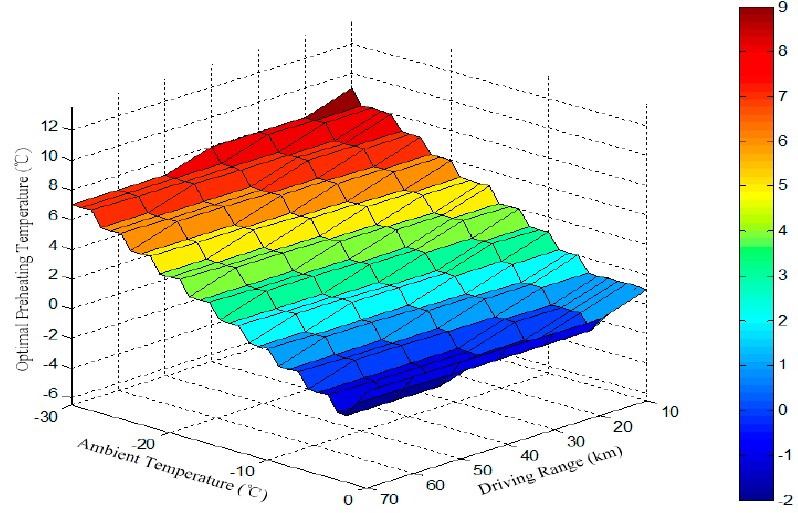
Figure 11. Optimal preheating target temperatures at different ambient temperatures and driving ranges.